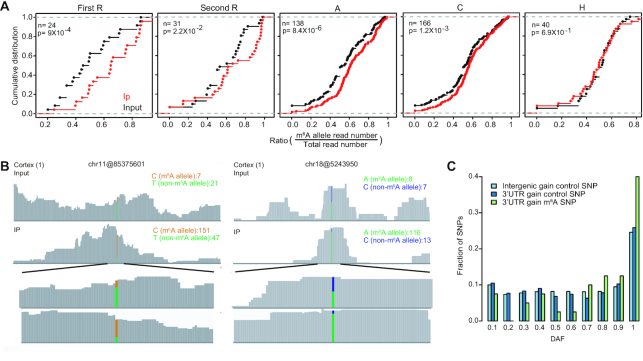
Positive selection inferred from SNP genotype data. (A) Comparison of the m6A allele ratio between IP and input samples of heterozygote m6A SNPs. Only heterozygote SNPs with one genotype matching the RRACH motif and the other genotype not matching the RRACH motif were considered. SNPs located in each position of RRACH motifs were analyzed, separately. P values were calculated with the Kolmogorov-Smirnov test. (B) Examples of m6A peaks with SNPs. For chr11@85375601 m6A site, the C allele (GAACT, m6A site is underlined and the SNP is marked in italics) matches the m6A motif and the T allele (GAATT) disrupts the motif. For chr18@5243950 m6A site, the A allele (AAACA) matches the m6A motif and the C allele (ACACA) disrupts the motif. For both sites, compared with the non-m6A allele, the m6A allele is highly enriched in the IP sample. (C) DAF distributions of 1,000 Genome Project SNPs of m6A RRAC motifs for 3′UTR sites. The derived alleles that create m6A motifs were analyzed. Two groups of control sites were selected: (1) ‘RRAC’ from all non-m6A RRACH motifs located at 3′UTR region; (2) ‘RRAC’ from all RRACH motifs in the intergenic region. P values were calculated with a one-sided Mann-Whitney U test comparing the DAF distribution of SNPs in m6A RRAC motif with the distribution of SNPs in control sites. 3′UTR control group versus m6A group, P = 0.00037; intergenic group versus m6A group, P = 0.000013.